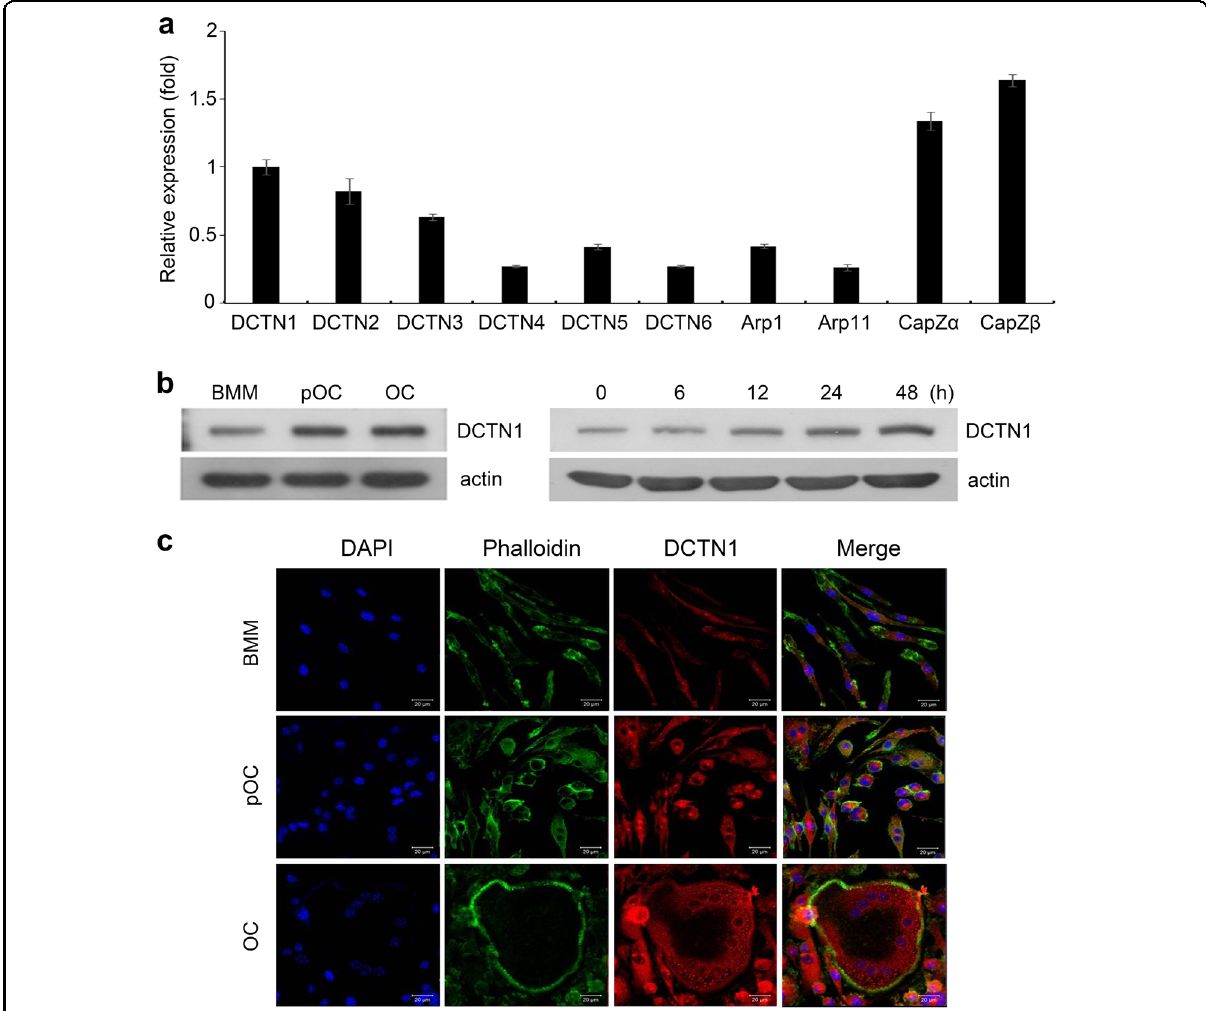
Fig. 1 DCTN1 is upregulated during OC differentiation. a BMMs were cultured in OC differentiation medium (ODM) containing 200 ng/ml RANKL for 2 days. DCTN1-6, Arp1/11, and CapZ α / β mRNA levels were analyzed by real-time PCR. b BMMs were cultured in ODM for 2 (pOC) or 4 days (OC) or for the indicated number of hours. DCTN1 protein levels were determined by western blotting. c BMMs were cultured in ODM for 2 (pOC) or 4 days (OC). The cells were immunostained using an antibody against DCTN1 and then incubated with a Cy3-conjugated secondary antibody. F-actin was stained with Alexa Fluor 488-conjugated